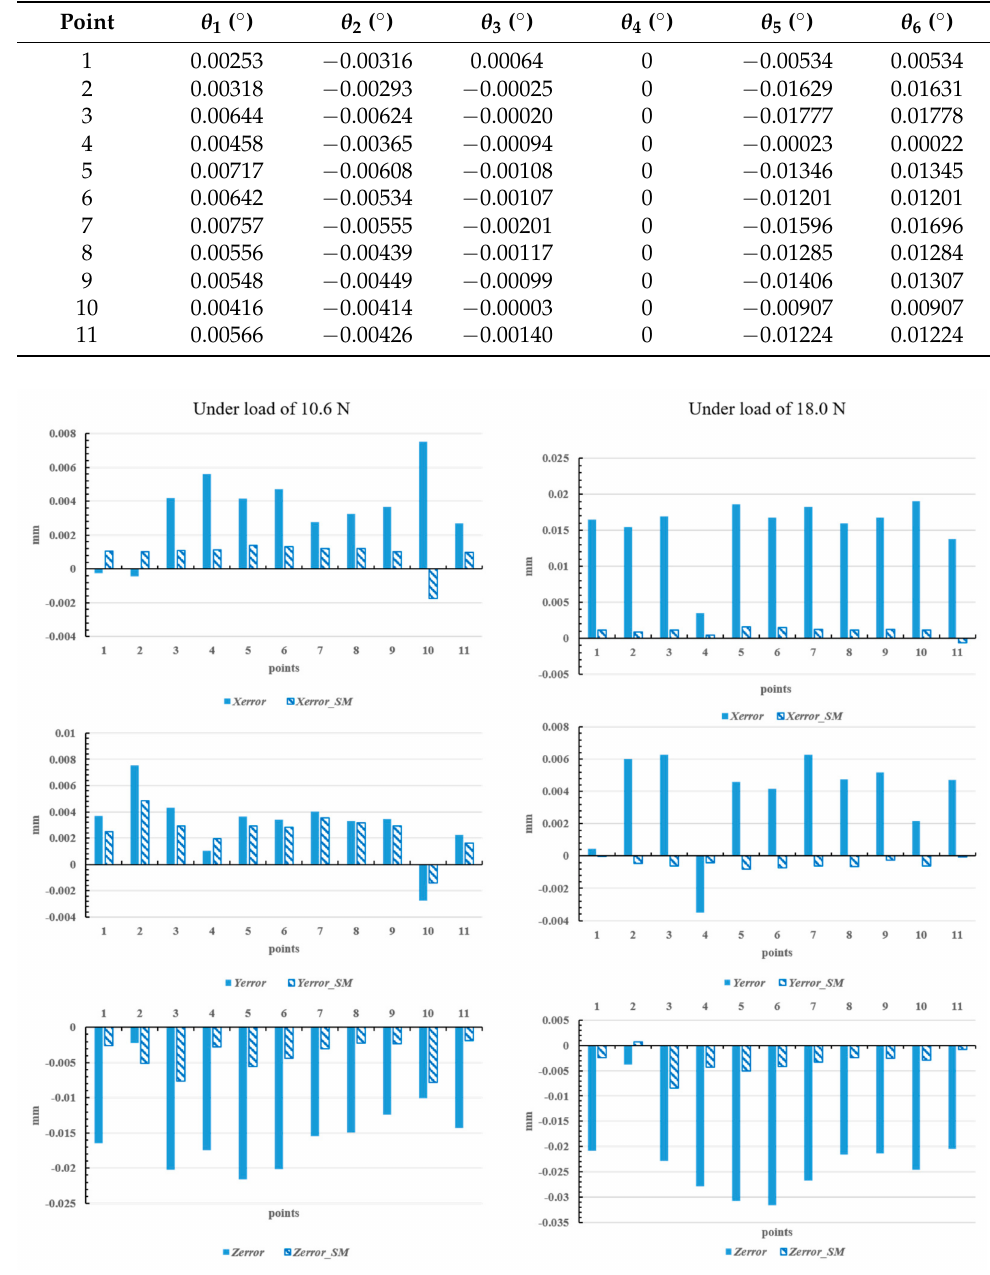
Figure 13. Position error before and after compensation under different